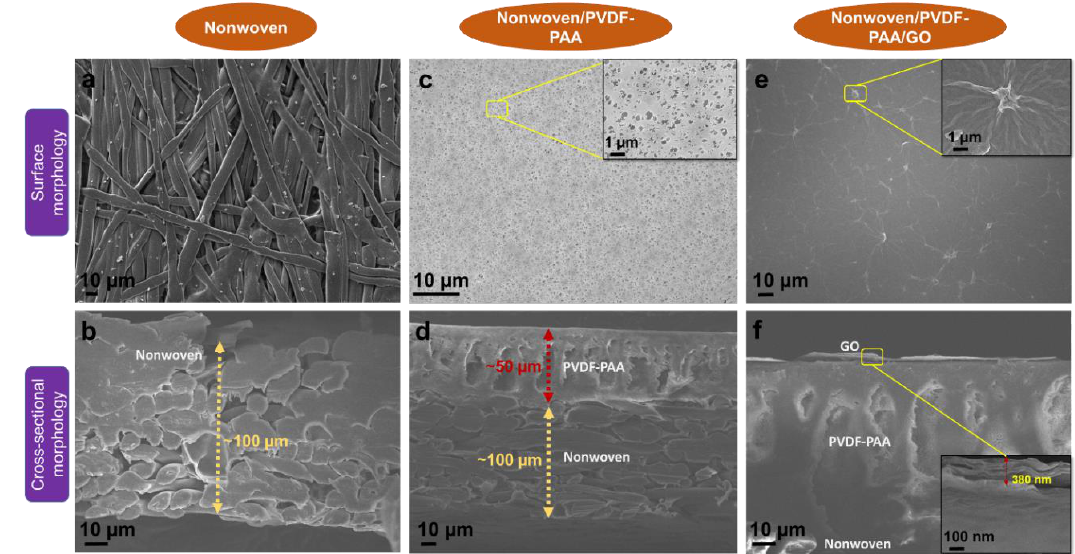
Figure 4. Surface and cross-sectional morphologies of ( a , b ) nonwoven, ( c , d ) nonwoven/ polyvinylidene fluoride-polyacrylic acid (PVDF-PAA) and ( e , f ) nonwoven/PVDF-PAA/GO composite membranes (inserted figures in ( c , e , f ) represent its higher magnifications).